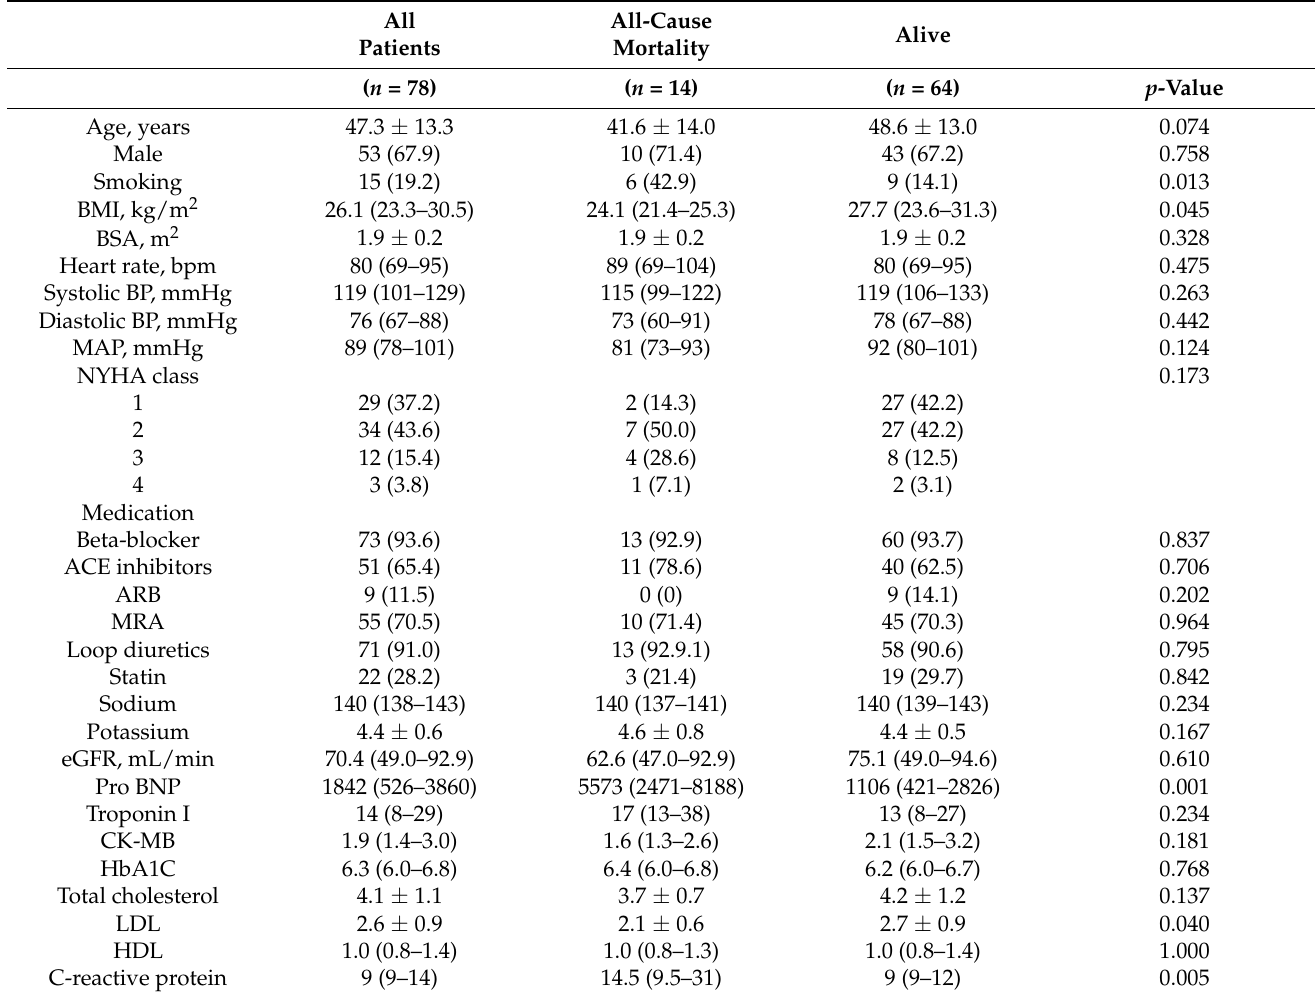
Table 1. Baseline clinical characteristics of patients with idiopathic dilated cardiomyopathy stratified according to one-year